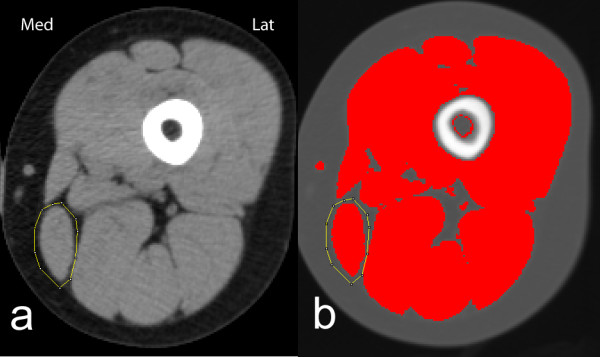
CT image of left thigh viewed with ImageJ. Musculus gracilis encircled. a) with level 50 HU and width 400 HU used when encircling the muscle and b) after highlighting areas with attenuation between 1 and 101 HU.